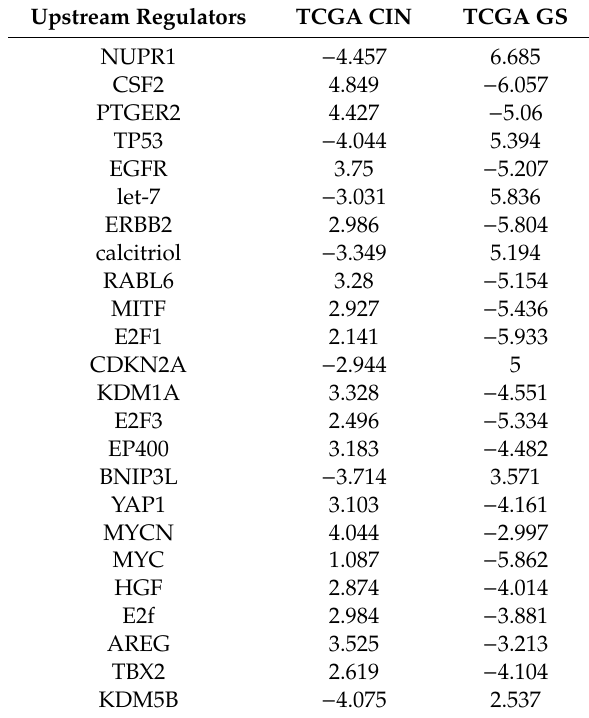
Table 7. Upstream regulators in intestinal- and di ff use-type gastric cancer (GC) (Top 25 regulators). Upstream Regulators TCGA